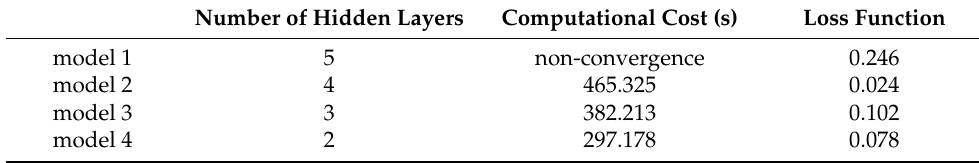
Table 3. Test results of different hidden Table 4. Test results of different neural nodes.